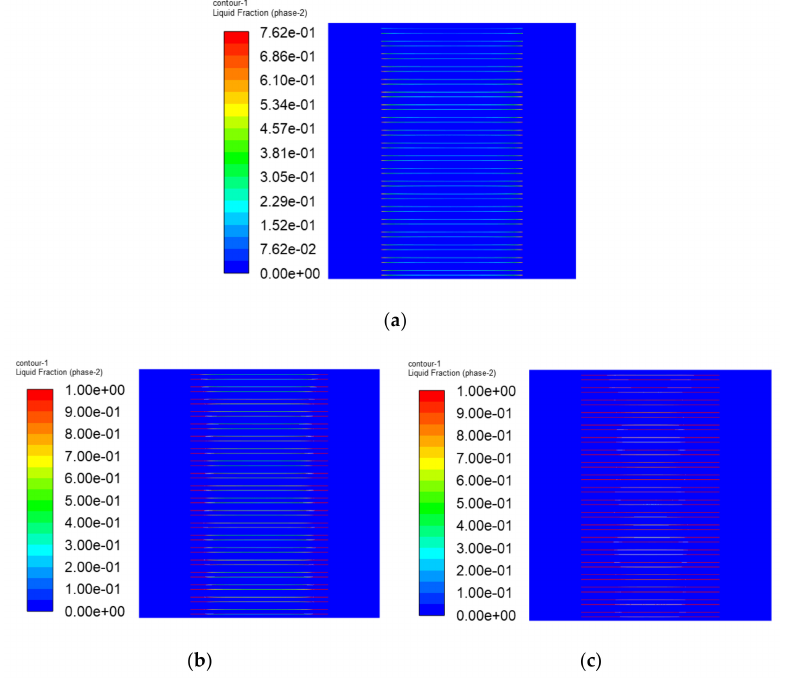
Figure 18. Liquid fraction contours of the PEMFC stack at di ff erent times; ( a ) t = 24 s, ( b ) t = 32 s, ( c ) t = 36